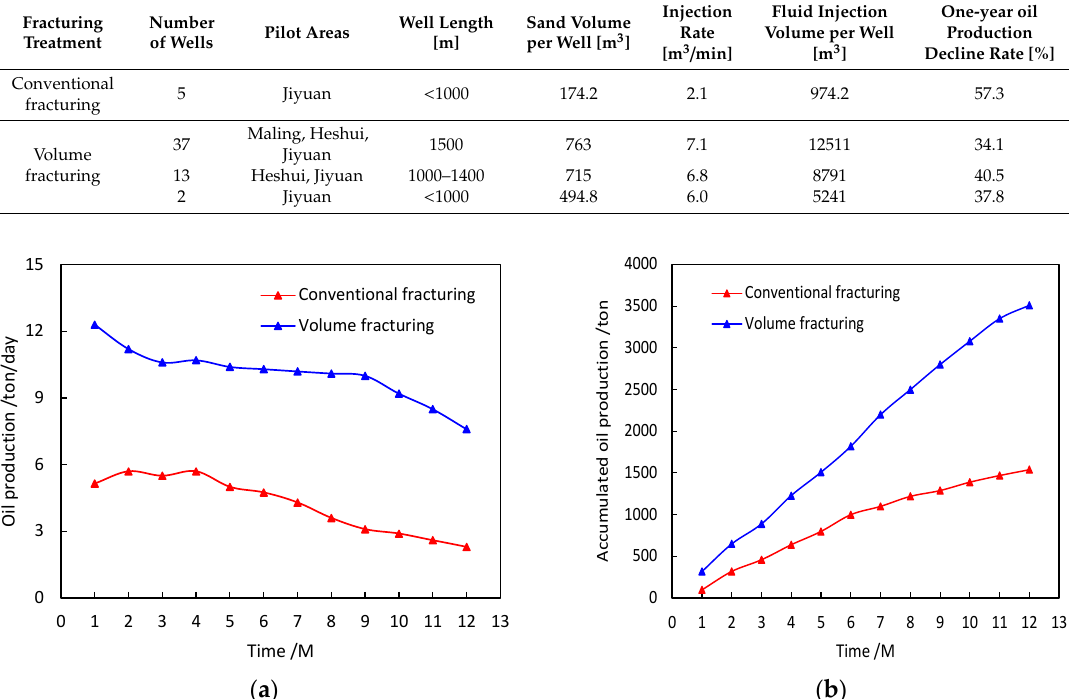
Figure 17. One-year tight oil production results in wells after volume fracturing treatment and in wells after conventional fracturing treatment: ( a ) Daily tight oil production, ( b ) accumulated tight oil production. Table 6. Decline of oil production in conventional fracturing and volume fracturing horizontal wells.